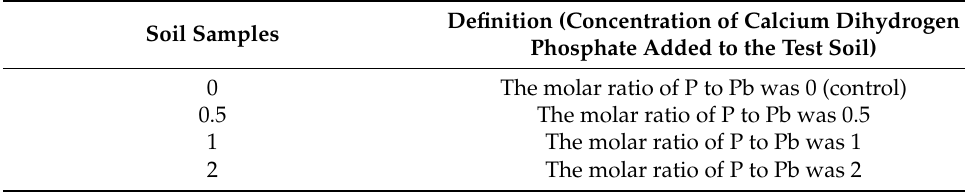
Table 3. The definition of each soil sample.